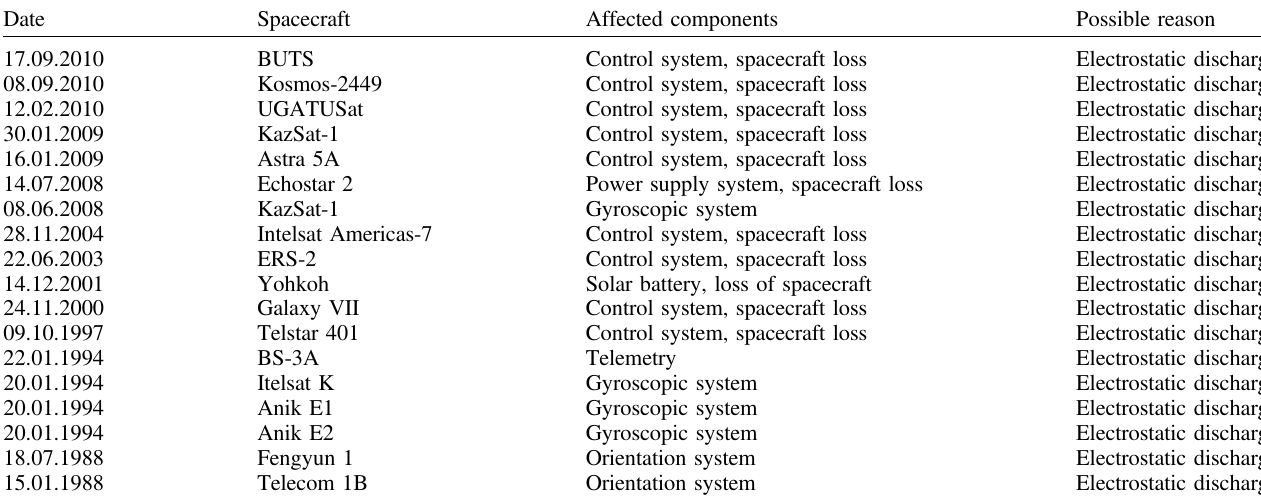
Table 1. Examples of the consequences of electrostatic discharges.